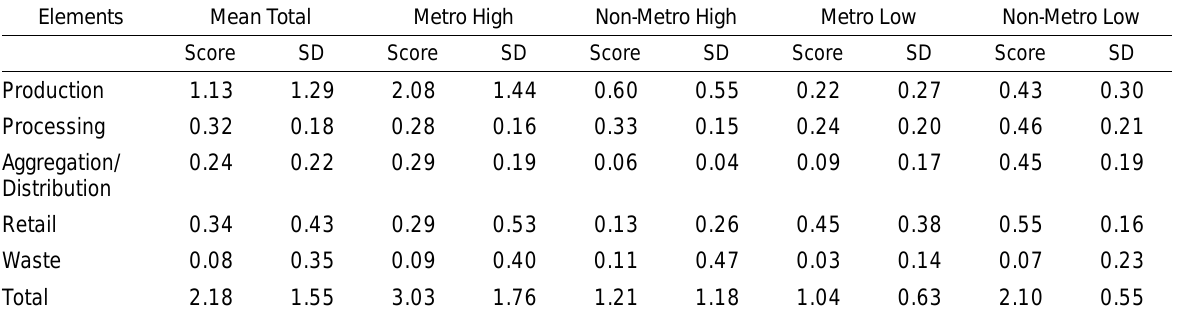
Table 4. Scores and Standard Deviations (SD) by Food County Group and Food System Element